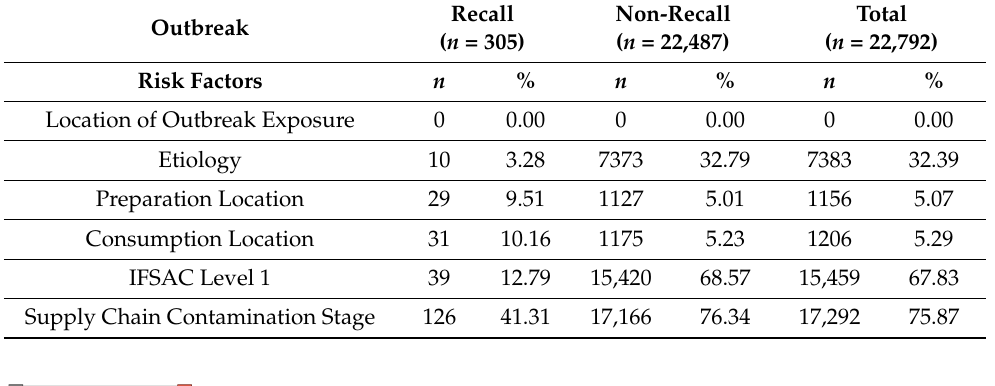
non-recalls had limited missing records for the preparation (9.51% and 5.01%, respectively) and consumption location (10.16% and 5.23%, respectively) of contaminated foods. Table 3. Frequency and percentage of outbreaks with missing information by recall status (total, recall, and non-recall) and risk factor. We extracted data from the electronic Foodborne Outbreak Reporting System (eFORS) and National Outbreak Reporting System (NORS) in 1998–2019. Risk factors include location of residence for ill persons, etiology of contaminant, location of preparation and consumption of contaminated foods, Interagency Food Safety Analytics Collaboration (IFSAC) Level 1 food categorization, and supply chain contamination stage. We list risk factors in ascending order by percentage of outbreaks with missing information.